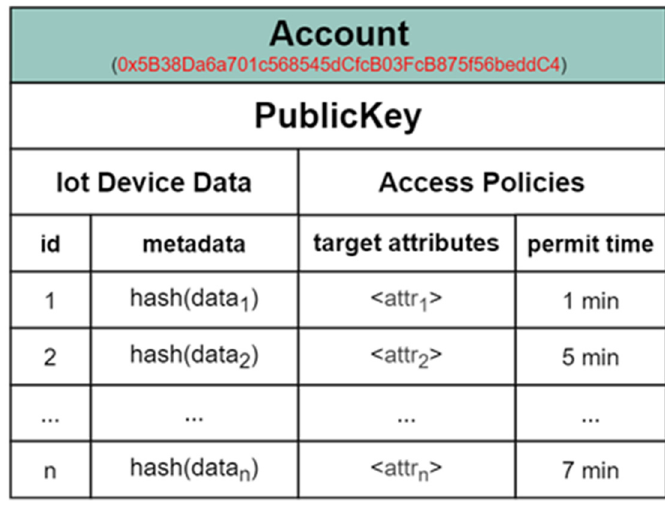
Figure 6. Data structure of the IoT device account.